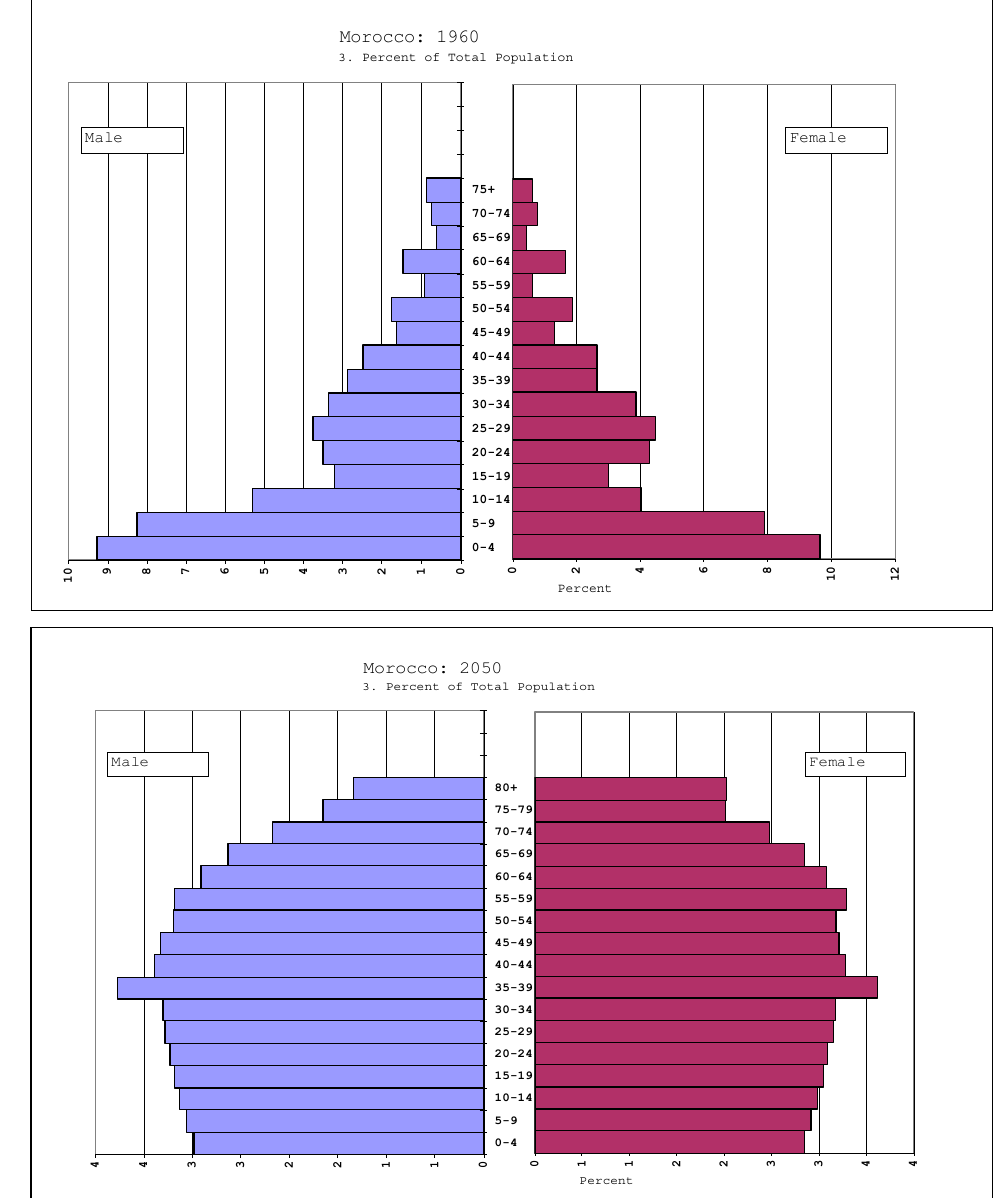
Figure 1. Evolution of demographic structure (%), Morocco, 2014–2050.